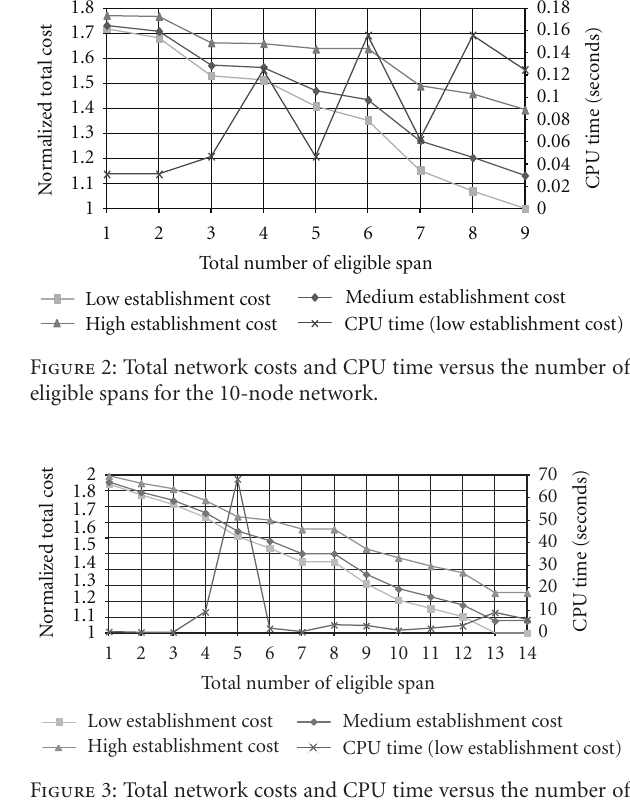
Figure 5: Total network costs and CPU time versus the number of eligible spans for the 25-node